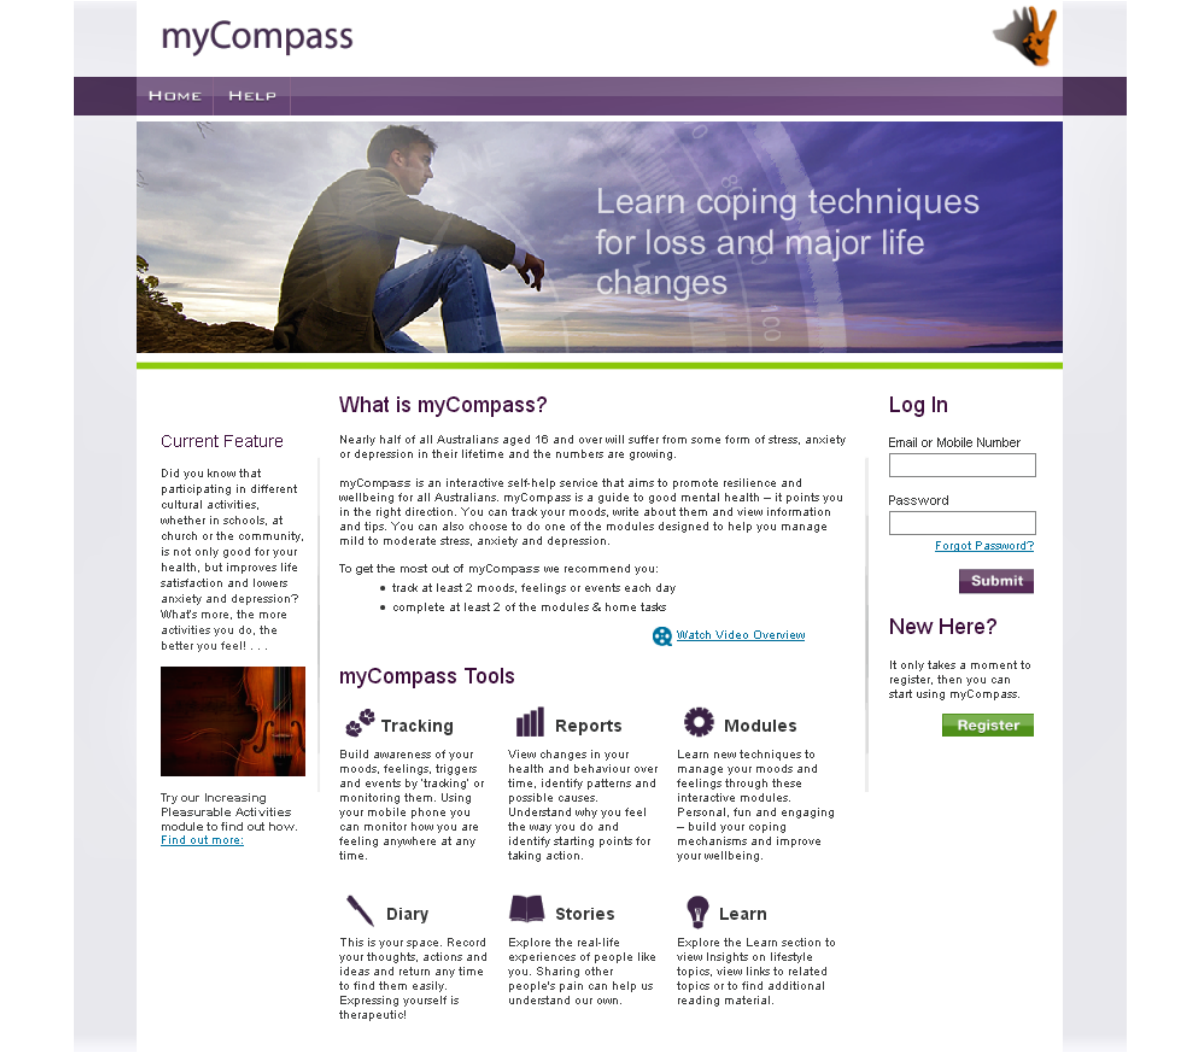
Figure 1. Screenshot of myCompass homepage with usage